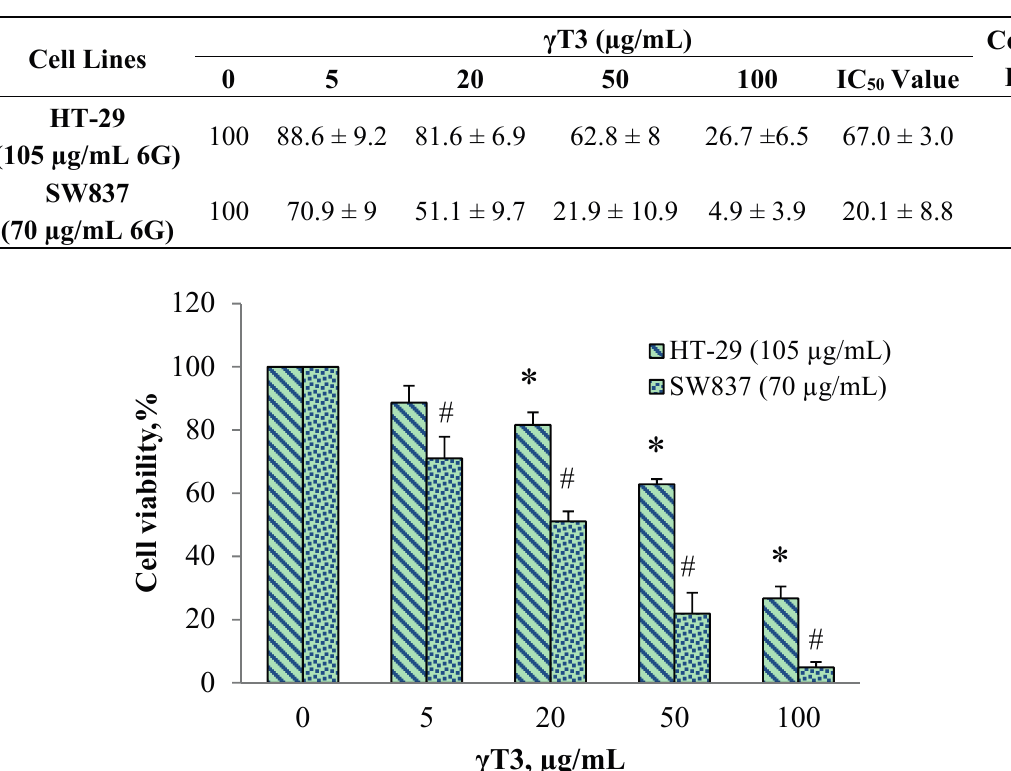
Table 2. Cell viability, IC 50 value, and combination index for combined 6G+ γ -T3 on each cell lines. Data are expressed as mean ± SD, of three dependent experiments ( n = 3).